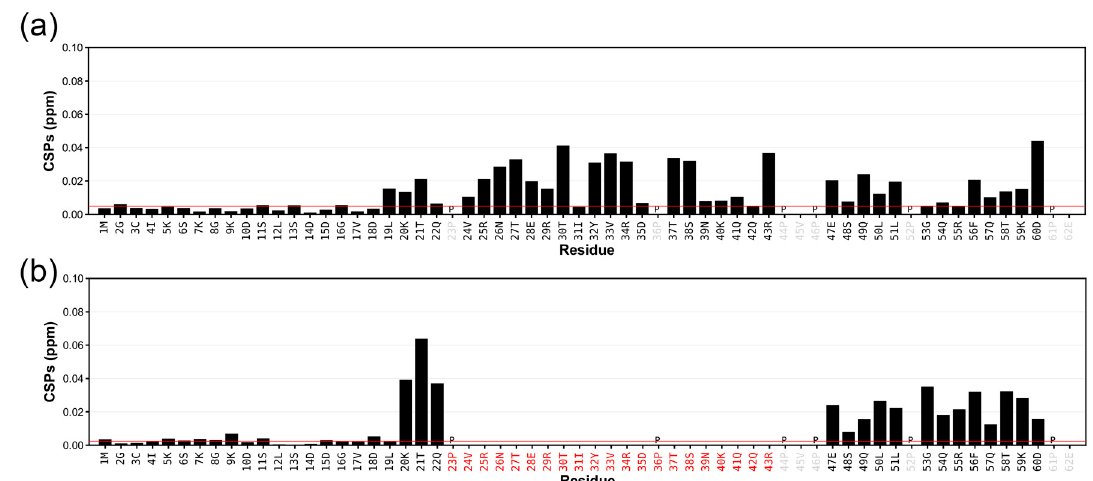
Figure 3. 1 H- 15 N combined chemical shift perturbations (CSPs) in ppm observed between ( a ) the LynA USH3 construct and the isolated LynA SH4-UD construct; ( b ) the LynB USH3 construct and the LynA USH3 construct; in red the residues that are absent in LynB with respect to LynA. For simplicity, the residue numeration for LynB is kept equal to that of LynA. The threshold red line indicates the average plus 5 standard deviations of the CSP values from the 10% least perturbed residues.